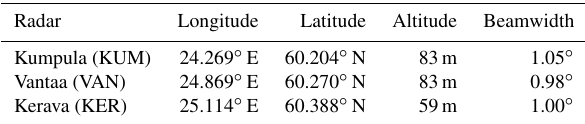
Table 1. Helsinki weather radar main